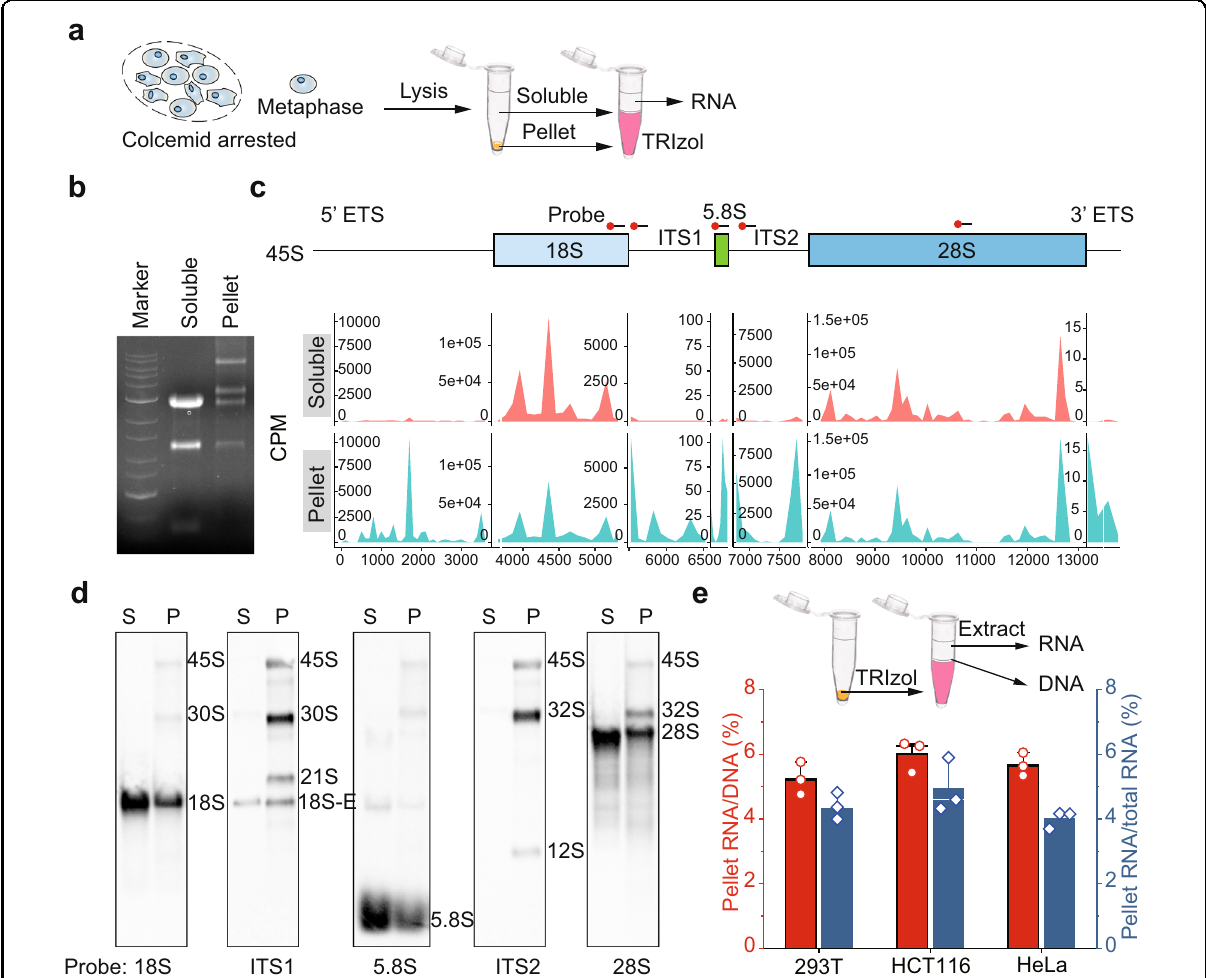
Fig. 1 rRNA associates with chromosomes during mitosis. a A schematic diagram shows the procedure of RNA puri fi cation from soluble and pellet fractions of metaphase cells. b Puri fi ed RNA is analyzed by agarose gel. c Distribution of RNA-seq reads (CPM) across the full-length 45S pre- rRNA sequence in soluble and pellet total RNAs. d Northern blot analysis of the RNAs from the soluble (S) and pellet (P) fractions with probes targeting 18S, ITS1, 5.8S, ITS2, and 28S regions. The position of northern blot probes is shown in c . e The ratio of RNA in the pellets to total DNA mass (left y axis) and the ratio of RNA in the pellets to total RNA (right y